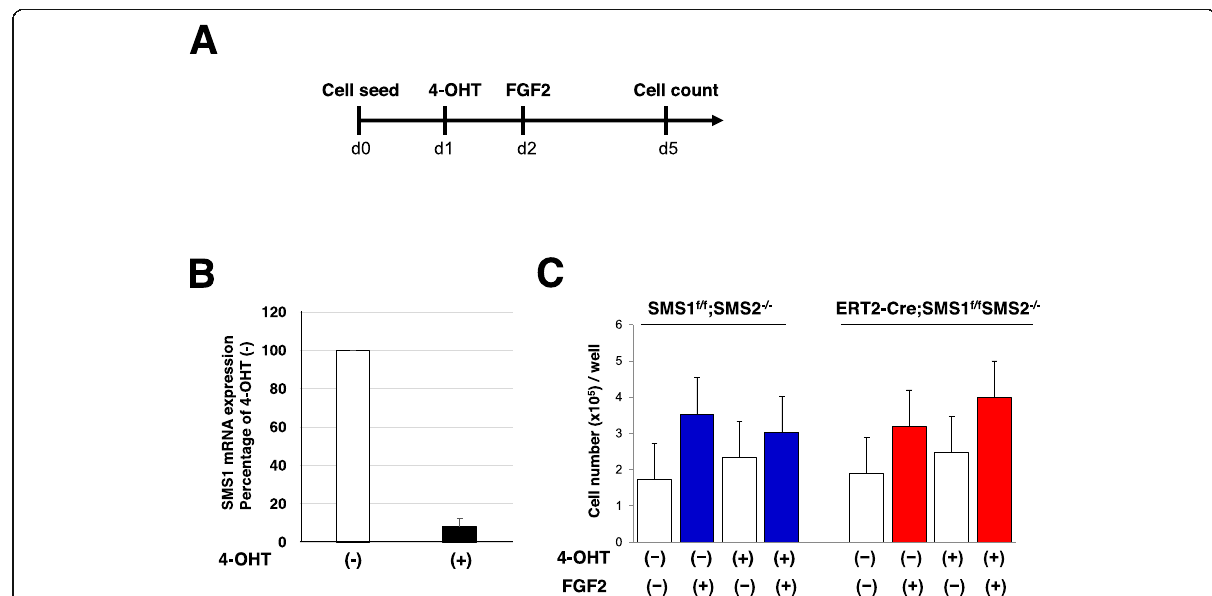
Fig. 4 Effects of SMS1 knock-out on osteoblast cell growth. a Schematic outline of the experimental design. Calvarial osteoblast cells were